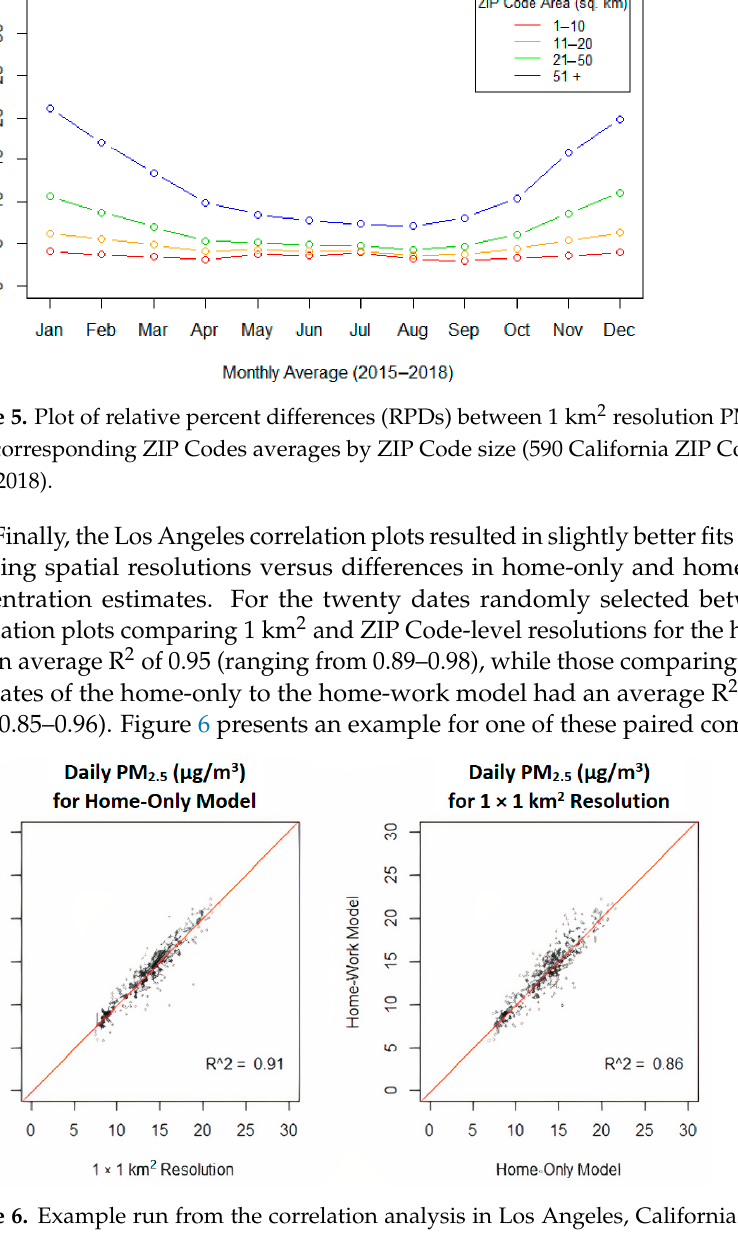
Figure 6. Example run from the correlation analysis in Los Angeles, California for one randomly selected date between 2015–2018 ( N = 20 dates for the full analysis). This analysis compares exposure bias due to spatial differences in spatial resolution (1 km 2 vs. ZIP Code) and exposure misclassification due to assumptions of daily exposures based solely on home address location. In the plot on the left, PM 2.5 (µg/m 3 ) from 1 × 1 km 2 resolutions vs. ZIP Code-level resolutions are compared for 100 “home” locations. The plot on the right compares PM 2.5 for 100 “home” vs. 100 “work” locations at a 1 × 1 km 2 resolution. A 1:1 line is shown in red for each